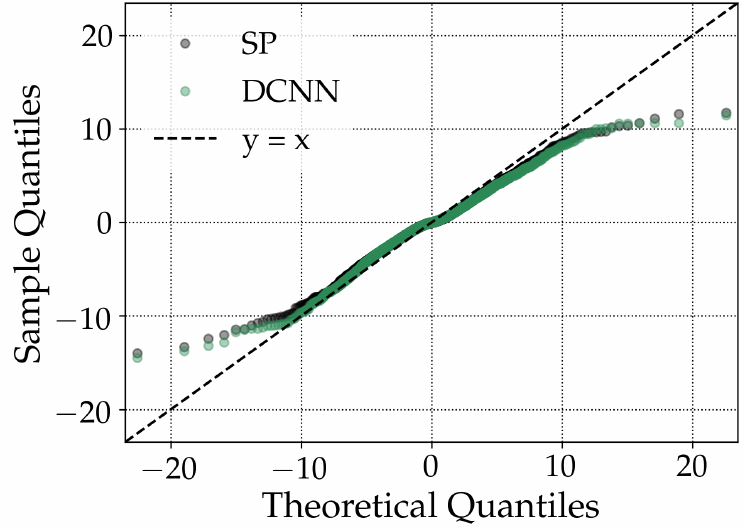
Figure 12. Normal Q–Q (quantile-quantile) plot of the forecasts residuals for SP and